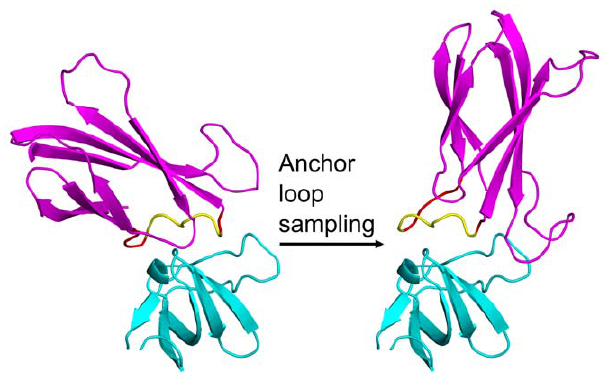
Figure 2. AnchoredDesign treatment of rigid-body and loop degrees of freedom. These complexes demonstrate how the AnchoredDesign protocol samples the rigid-body degree of freedom via loop sampling. These complexes are colored as in Figure 1: cyan for the target, yellow for the anchor, and magenta for the scaffold. The flexible residues of the loop containing the anchor are colored red. The two complexes are related only by the alteration of the backbone torsion angles of the red positions; the overall viewpoint has not been rotated (notice the targets are identical). Remodeling of this loop (and no other changes) produces a large rigid-body like change between the two partners, while leaving the anchor/target interface and both protein cores intact. This allows sampling of the target/scaffold interface without losing the anchor information.